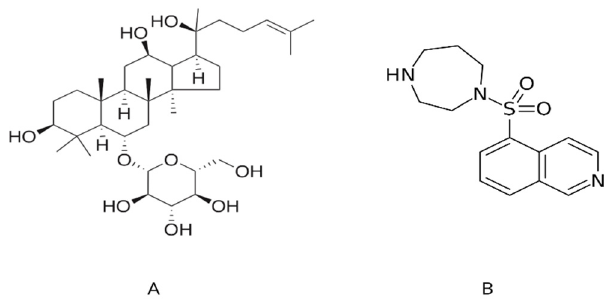
Figure 1. The two-dimensional graphical representation of ( A ) ginsenoside Rh1 from Panax ginseng and ( B ) fasudil, a known inhibitor of ROCK1.